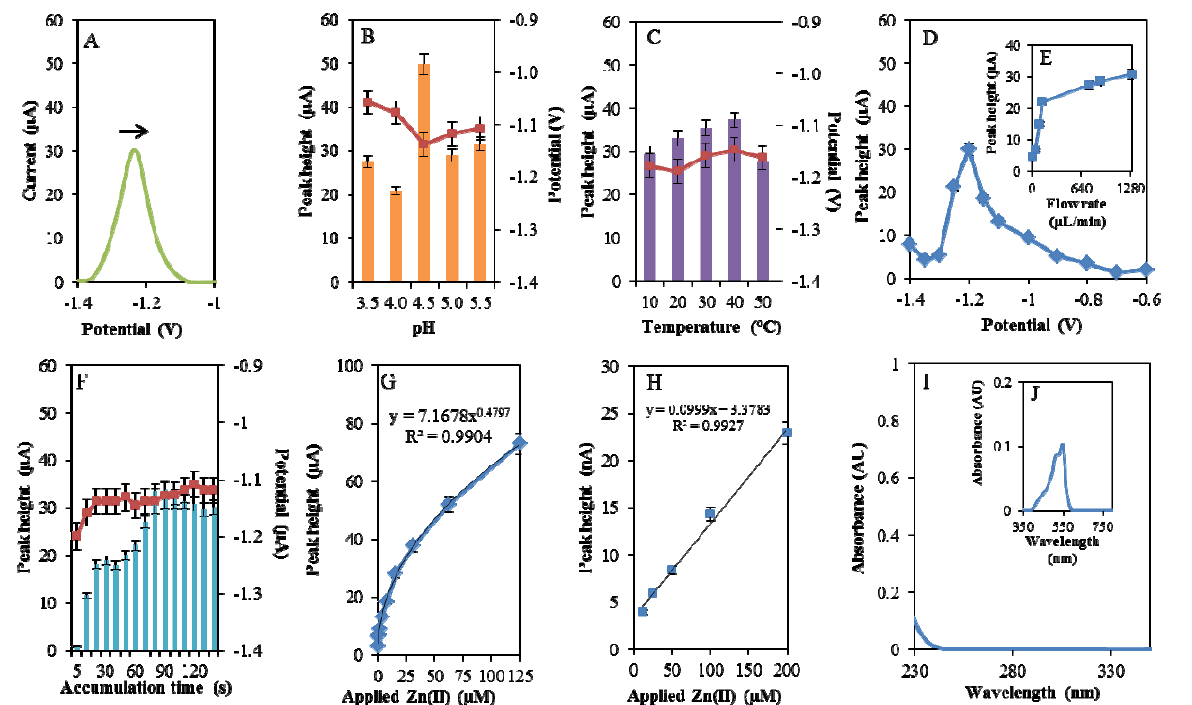
Figure 3. Electrochemical and spectrophotometric analysis of Zn(NO